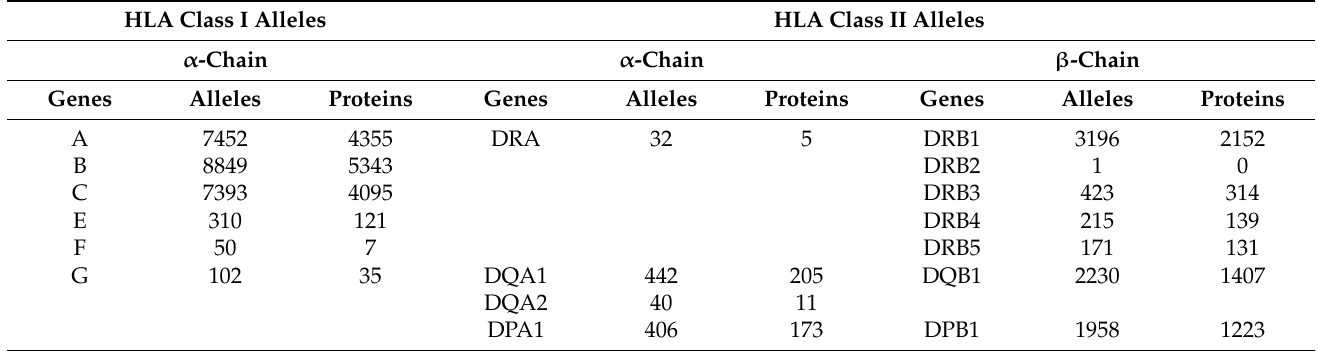
Table 1. The diversity of α -chain of HLA-I and α - and β -chains of HLA-II is exemplified by the number of the named alleles and proteins (Based on December 2021, IPD-IMGT/HLA Database) 1,2 . HLA Class II